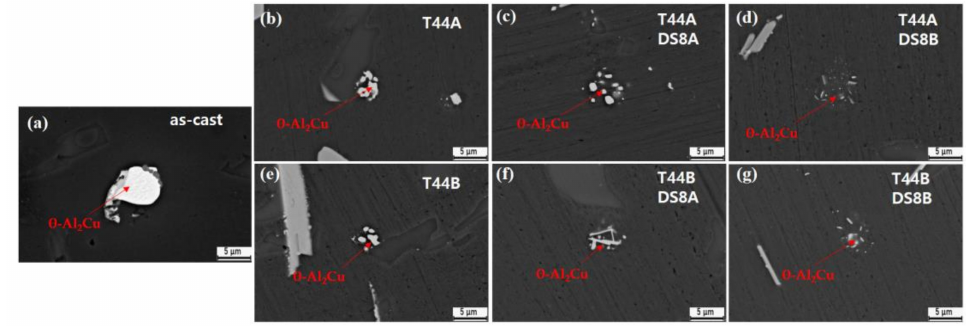
Figure 3. BSE micrographs of the Al6Si2Cu alloy showing dissolution of Al2Cu phase: ( a ) coarse Al2Cu phase in as-cast sample, ( b ) T44A, ( c ) T44A-DS8A, ( d ) T44A-DS8B, ( e ) T44B, ( f ) T44B-DS8A, and ( g )